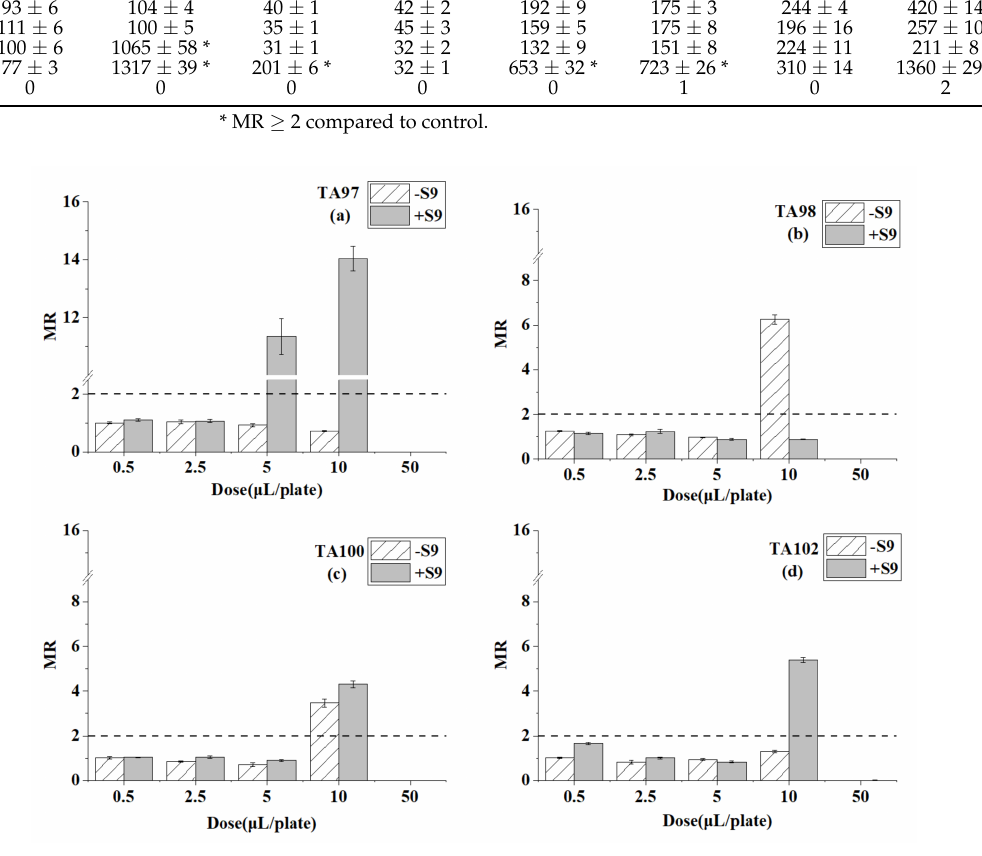
Figure 2. Mutagenesis of chloroform to four strains in the presence and absence of S9 liver extract; ( a ) TA97 strain; ( b ) TA98 strain; ( c ) TA100 strain; ( d ) TA102 strain. The mutagenicity ratio (MR) is the average ratio ( ± SE) from three parallel